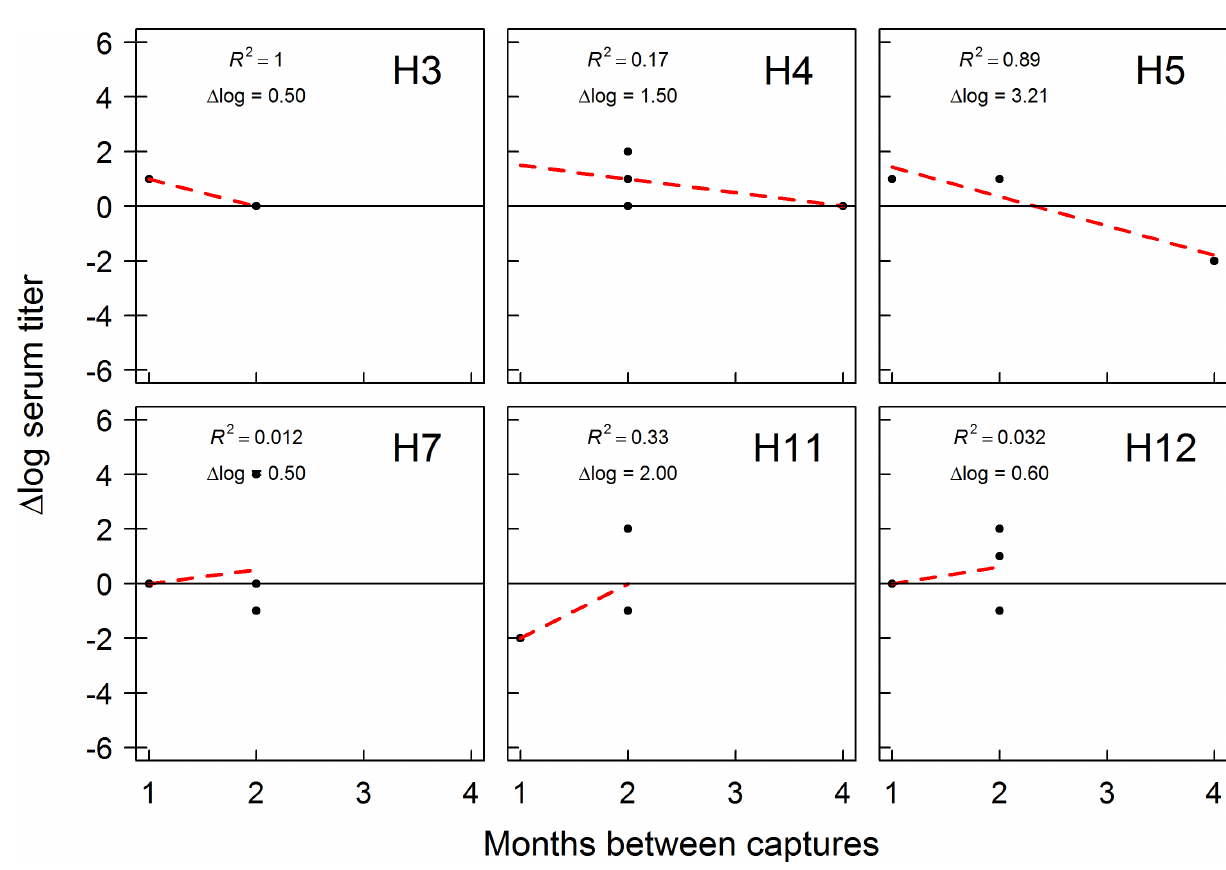
Fig 4. Trends in antibody production to influenza A viruses (IAVs) by mallards sampled in Fairbanks, Alaska. Mallards were captured and sampledfrom August 2012 through April of 2013. Analysis includedsamples obtainedfrom individualsdetermined to be seropositive on multiple capture occasionswith bELISA. Time intervalson the x-axis represent the numberof months betweenfirst and one randomly selectedcapture occasion. The dashedred line represents a linear regressiontrend line and associated R-squared value.